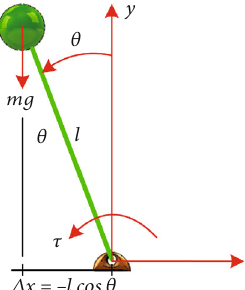
Figure 2: Variables involved in the inverted pendulum